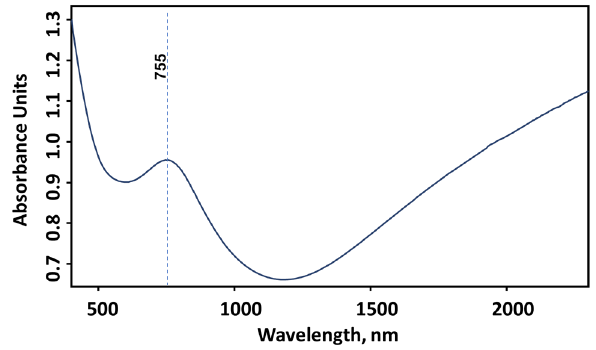
Figure 3. UV-Vis-NIR absorption spectrum of dried 70 nm thick Ti 3 C 2 T x MXene film on the glass slide.